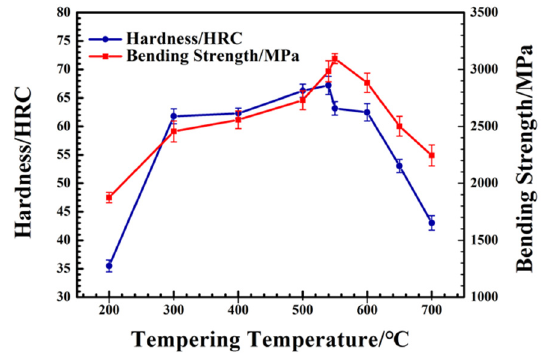
Figure 2. Hardness and Bending Strength of M42 HSS under Different Tempering Temperatures.